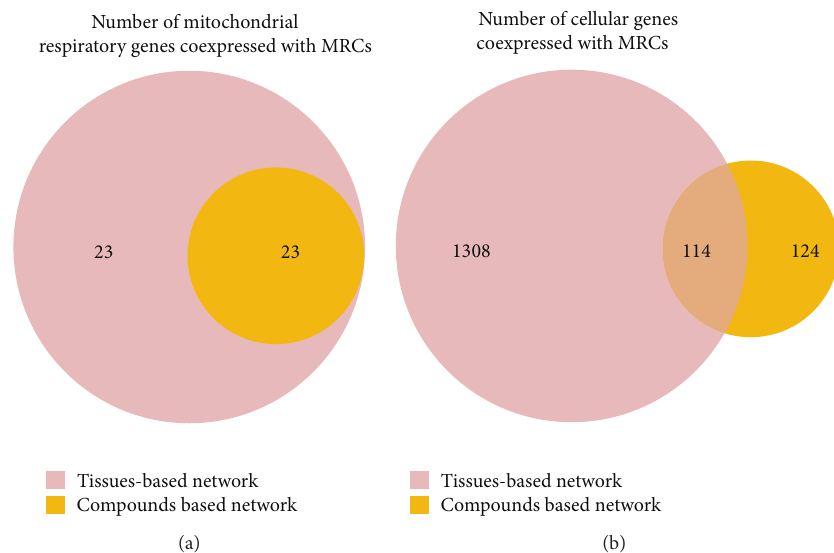
Figure 1: Genes significantly coexpressed with MRCs in normal and chemically treated tissues. (a) Self-connections among mitochondrial respiratory complexes. (b) Coexpressed cellular